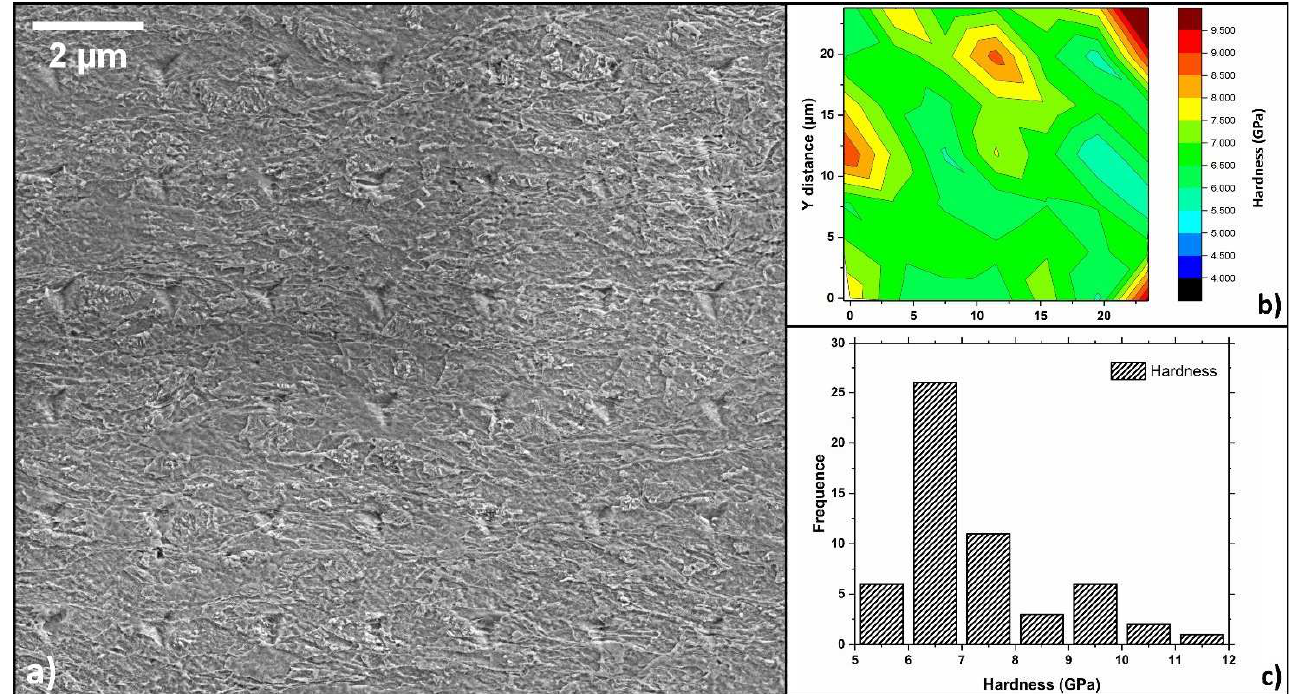
Figure 5. ( a ) Nano-hardness grid and ( b ) the resulting contour map. ( c ) Summary of results from ( a ) and ( b ) in a histogram showing a bimodal distribution.